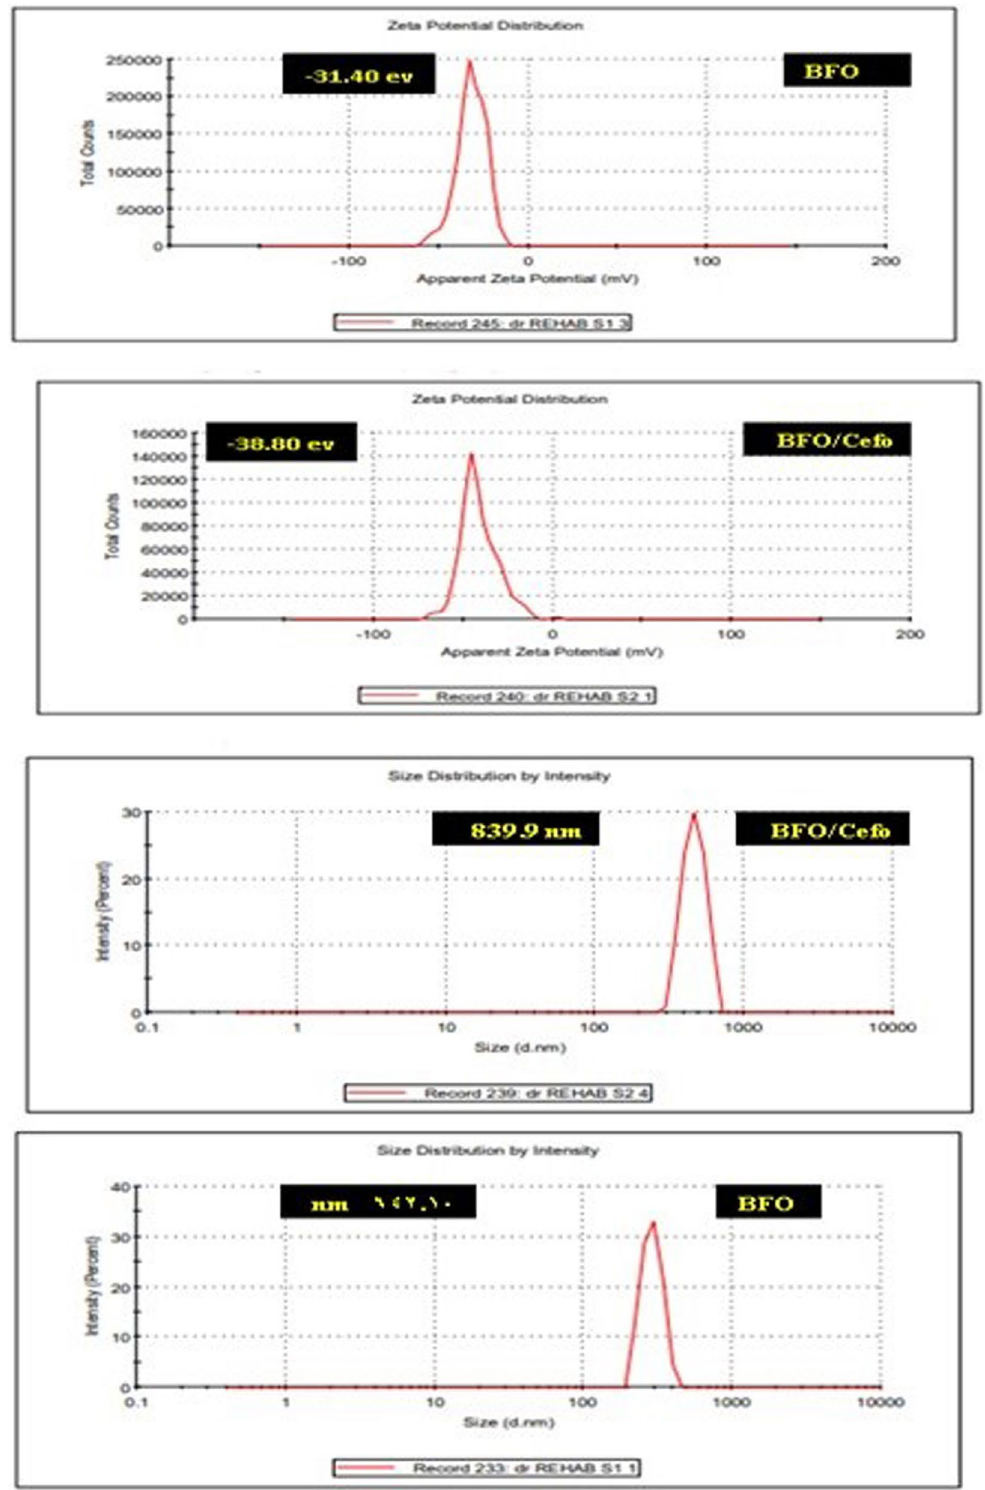
Figure 5. Zeta potential and partial size of the prepared BFO and